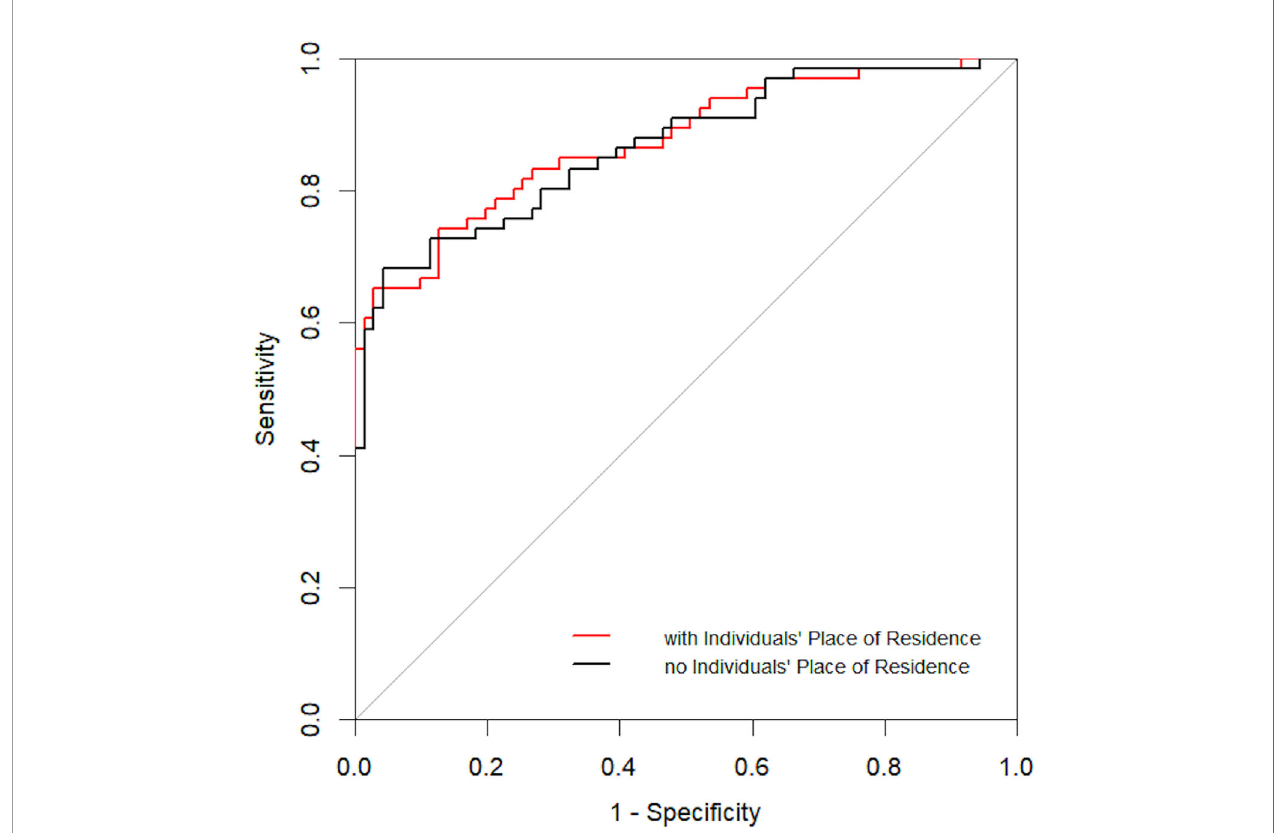
FIGURE 5 | ROC curve for independent risk factors with and without place of residence of